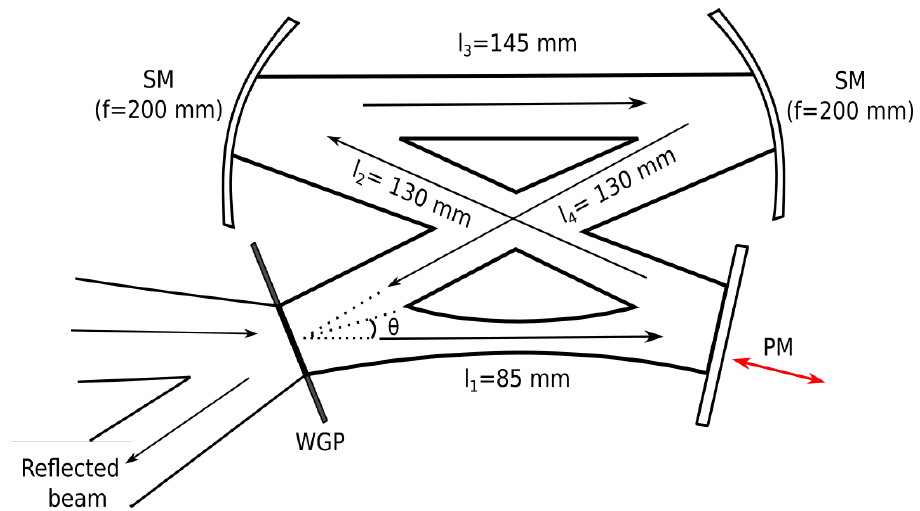
Figure 1. Configuration of the bow-tie cavity consisting in a plane gold mirror, two gold spherical mirrors (SM), and a wire grid polarizer (WGP) as input/output coupler. The red arrows indicate the motorized translating stage for the plane gold mirror.